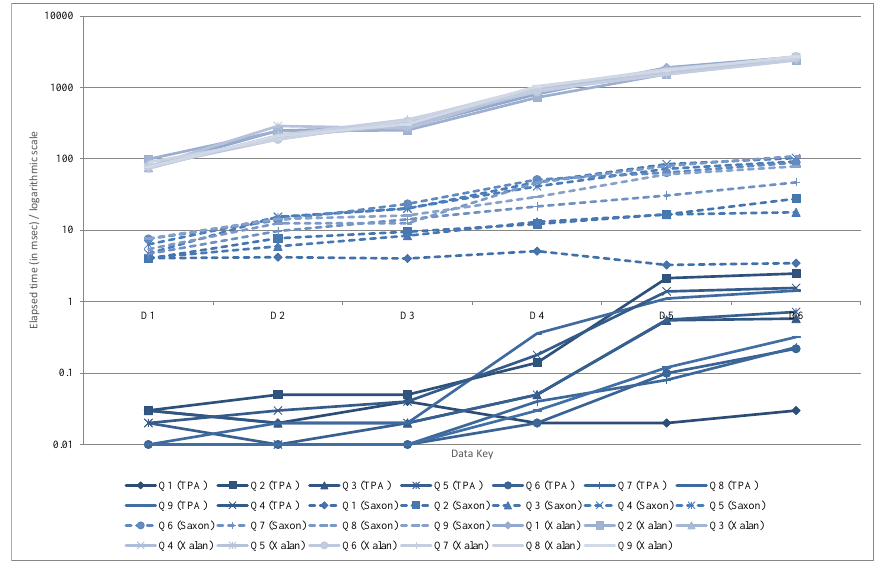
Figure 11. Performance comparison of TPA, Saxon and Xalan (logarithmic